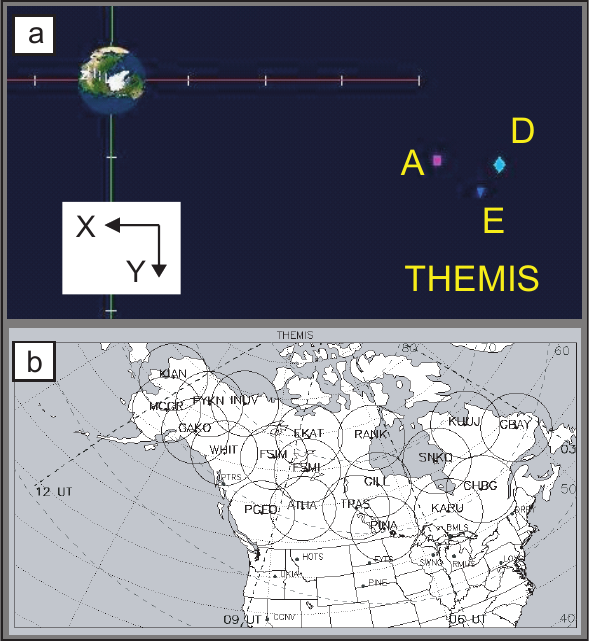
Fig. 1. (a) Locations of the THEMIS spacecraft, projected onto the GSM X-Y plane, during the substorm on 19 February 2008 at 05:25UT: TH-A ( − 9.35, 2.26, − 2.5), TH-D ( − 11.17, 2.38, − 2.73), and TH-E ( − 10.62, 3.21, − 2.58) in GSM coordinates in units of R E . The estimated distance from the nominal neutral sheet is less than 0.1 R E for all three spacecraft. (b) Locations of the THEMIS ground observatories in Northern America. Circles indicate the fields of view of the all-sky